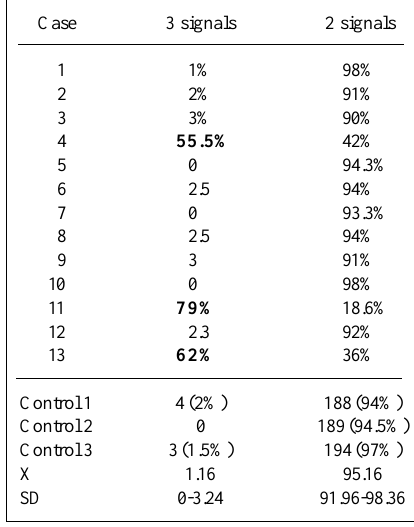
3 signals = Visualization of 3 fluorescent signals in cell; 2 signals = visualization of 2 fluorescent sig- nals in cell; X = mean; SD = standard